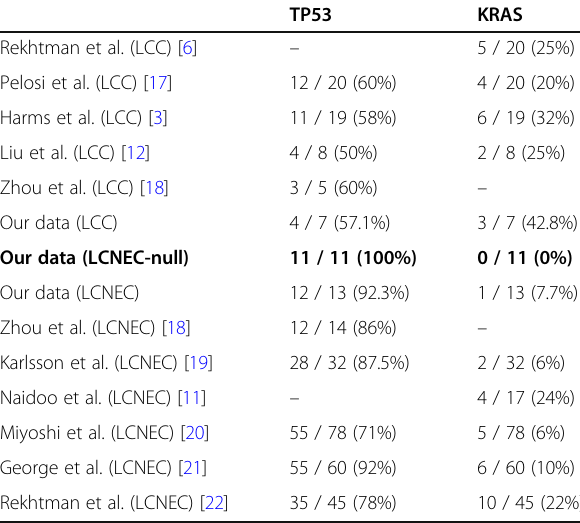
Table 2 Comparison of the mutation frequency of TP53